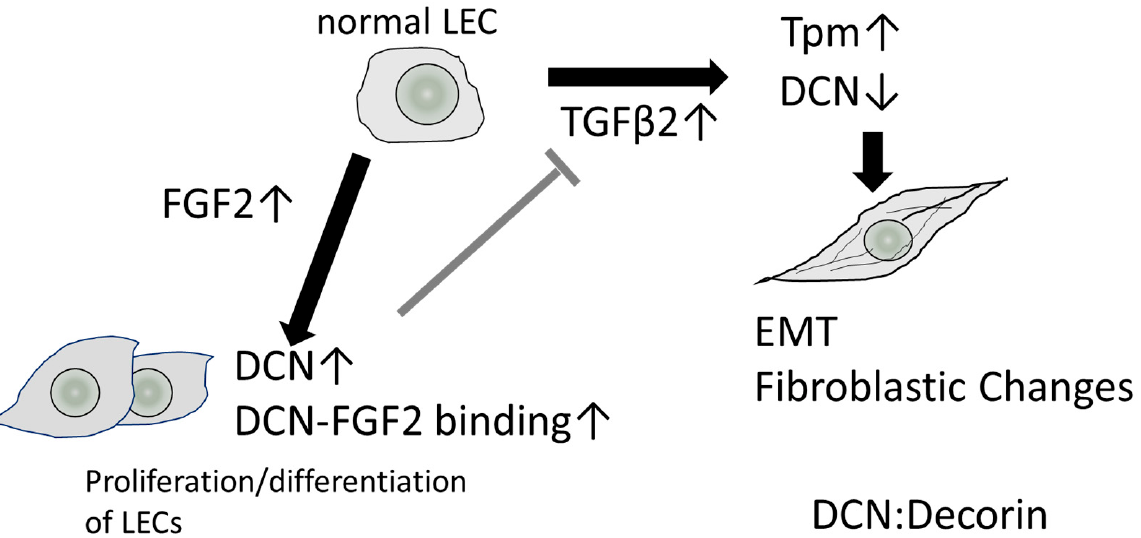
Figure 3. Schematic representation of the role of decorin (DCN) in the LECs. FGF2 induces the expression of DCN, but its mechanism is unclear. FGF2 binds to the GAG chain of DCN enhancing the activity of FGF2 and potentially promoting LEC proliferation and differentiation. Higher levels of DCN bind to TGF- β and inhibit its activity. On the other hand, TGF- β binds to the promoter of DCN and represses decorin expression, possibly promoting EMT and fibrosis. Increased expression of decorin inhibits the expression of Tpm1 and Tpm2 and may promote normal cell growth and wound healing. DCN, decorin; LECs, lens epithelial cells; FGF2, fibroblast growth factor 2; GAG, glycosamino-glycan; TGF- β , transforming growth factor- β ; EMT, epithelial–mesenchymal transition.